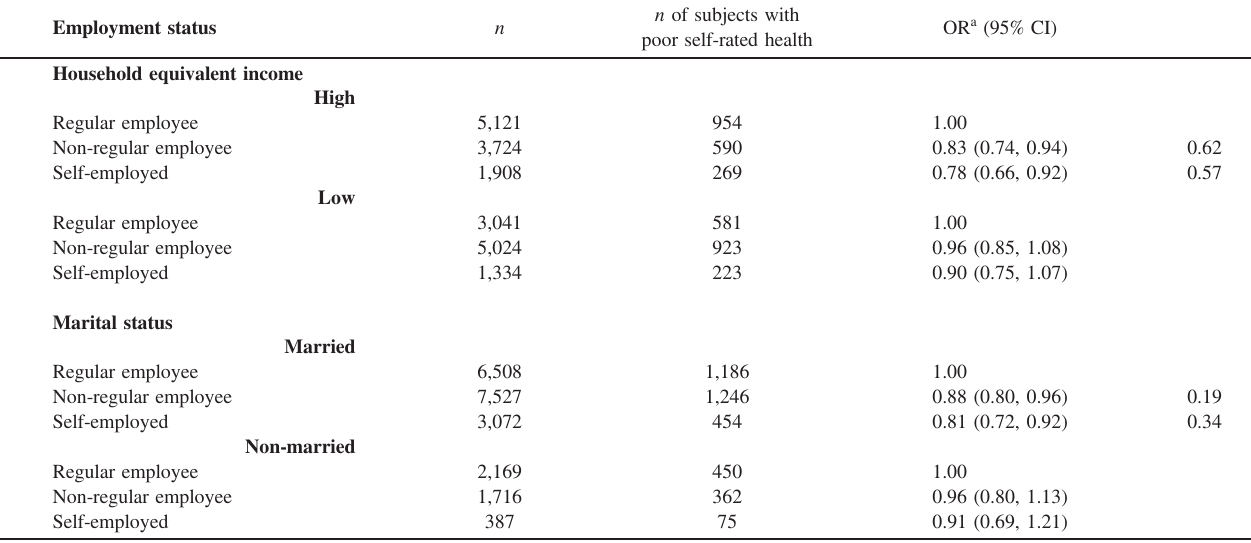
Table 4. Adjusted a ORs of employment type for poor self-rated health among Japanese middle-aged women, strati fi ed by household